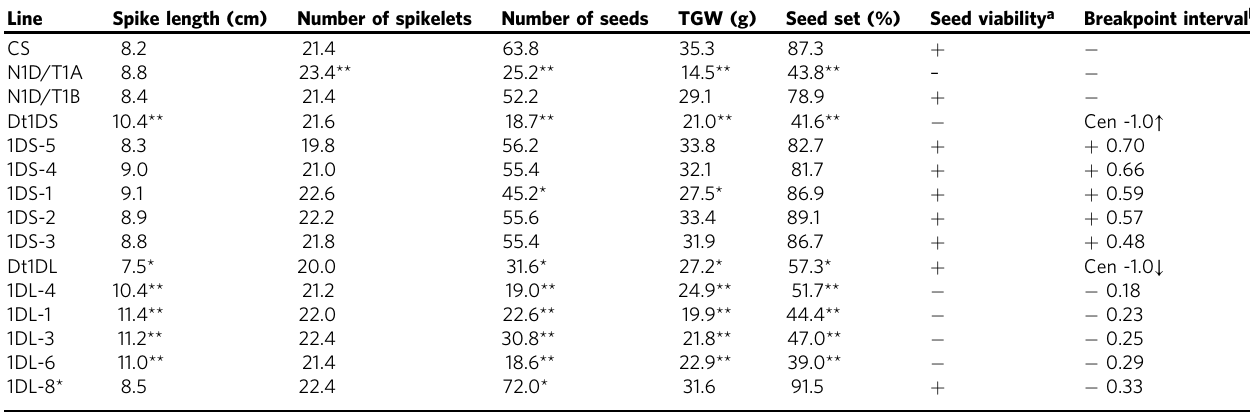
Table 1 Characteristics of main spike (MS) of hexaploid wheat CS, N1D/T1A, N1D/T1B, Dt1DS, Dt1DL, and CS deletion lines of chromosome 1D ( fi eld experiment,